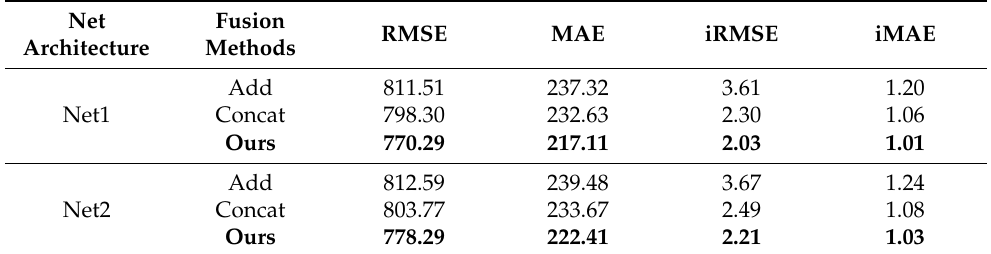
Table 3. The results of the different fusion methods using the KITTI validation